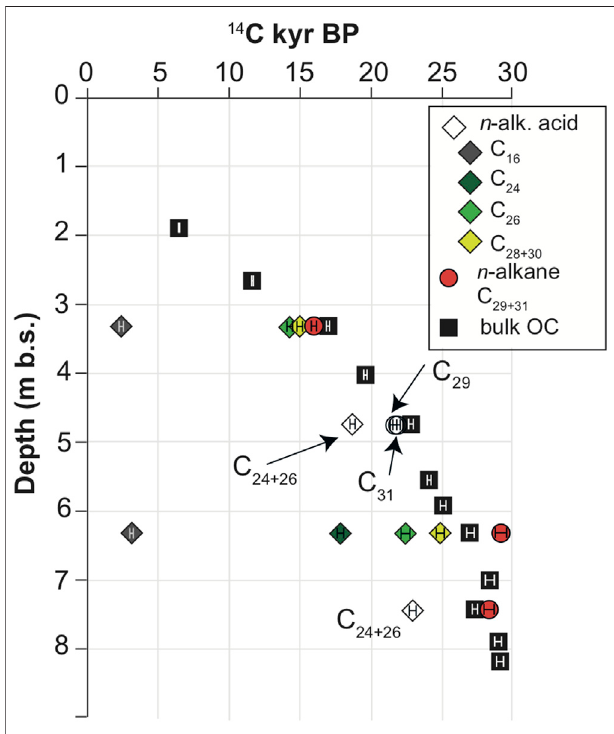
FIGURE 5 | Conventional 14 C ages of bulk organic carbon (OC) and of n -alkanes and n -alkanoic acids versus depth. Symbols include error bars.